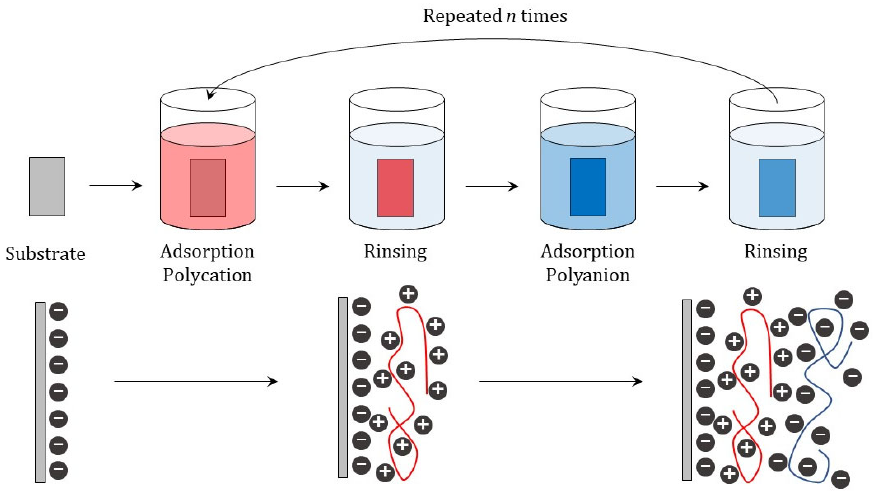
Figure 1. Sketch representing the use of dip ‐ coating deposition for the fabrication of LbL materials using a negatively charged flat substrate as template. Reprinted from Mateos ‐ Maroto et al. [42], with permission under Open access CC BY 4.0 license, https://creativecommons.org/licenses/by/4.0/ (ac ‐ cessed 20 January 2021).